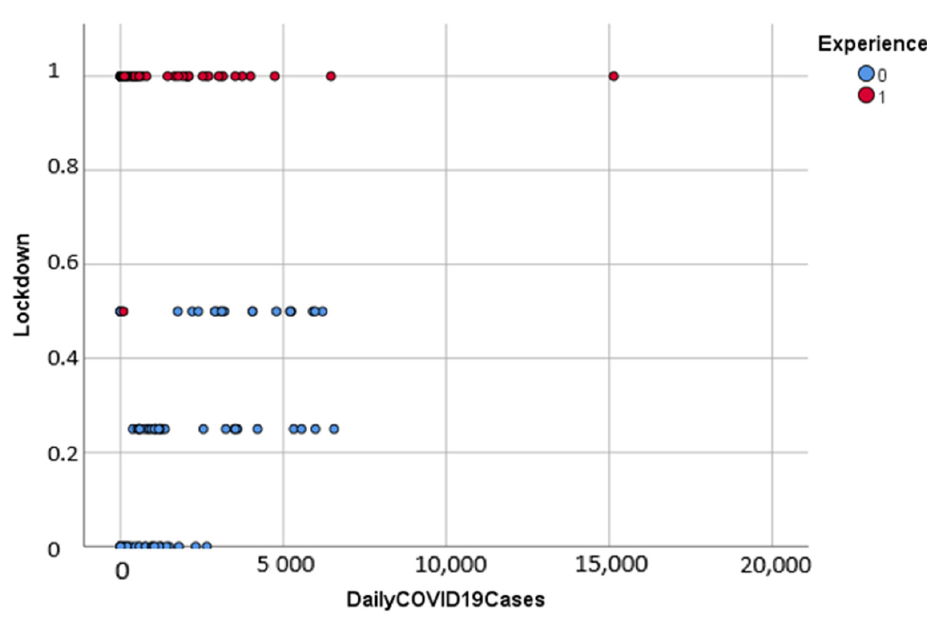
Figure 3. Grouped scatterplot of lockdown and daily Covid-19 cases by experience. Table 3 displays the Pearson correlation between the independent variables among each other and between every independent variable and the daily cases of COVID-19. Table 3. Pearson correlation between the factors and the dependent variable .